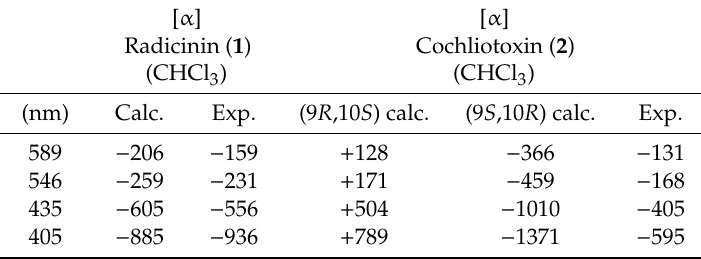
Table 1. Comparison of Experimental and Calculated Specific OR Values at Four Di ff erent Wavelengths for Radicinin ( 1 ) And Cochliotoxin ( 2 ). Experimental ORD was Measured in Chloroform